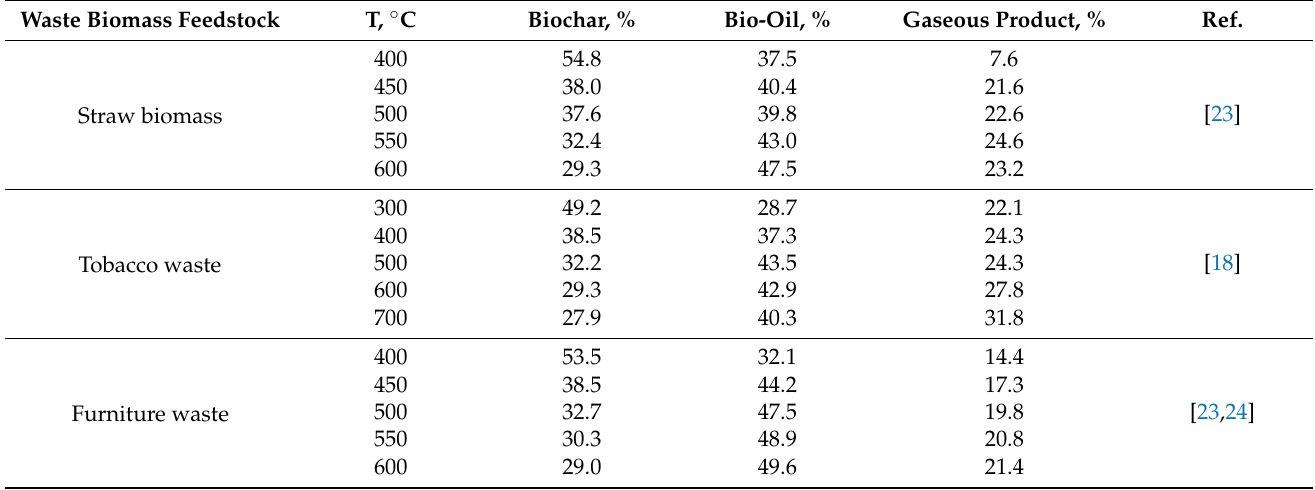
Table 1. Impact of pyrolysis process parameters on high-value products from waste biomass feedstocks. Waste Biomass Feedstock T, ◦ C Biochar, % Bio-Oil, % Gaseous Product, %